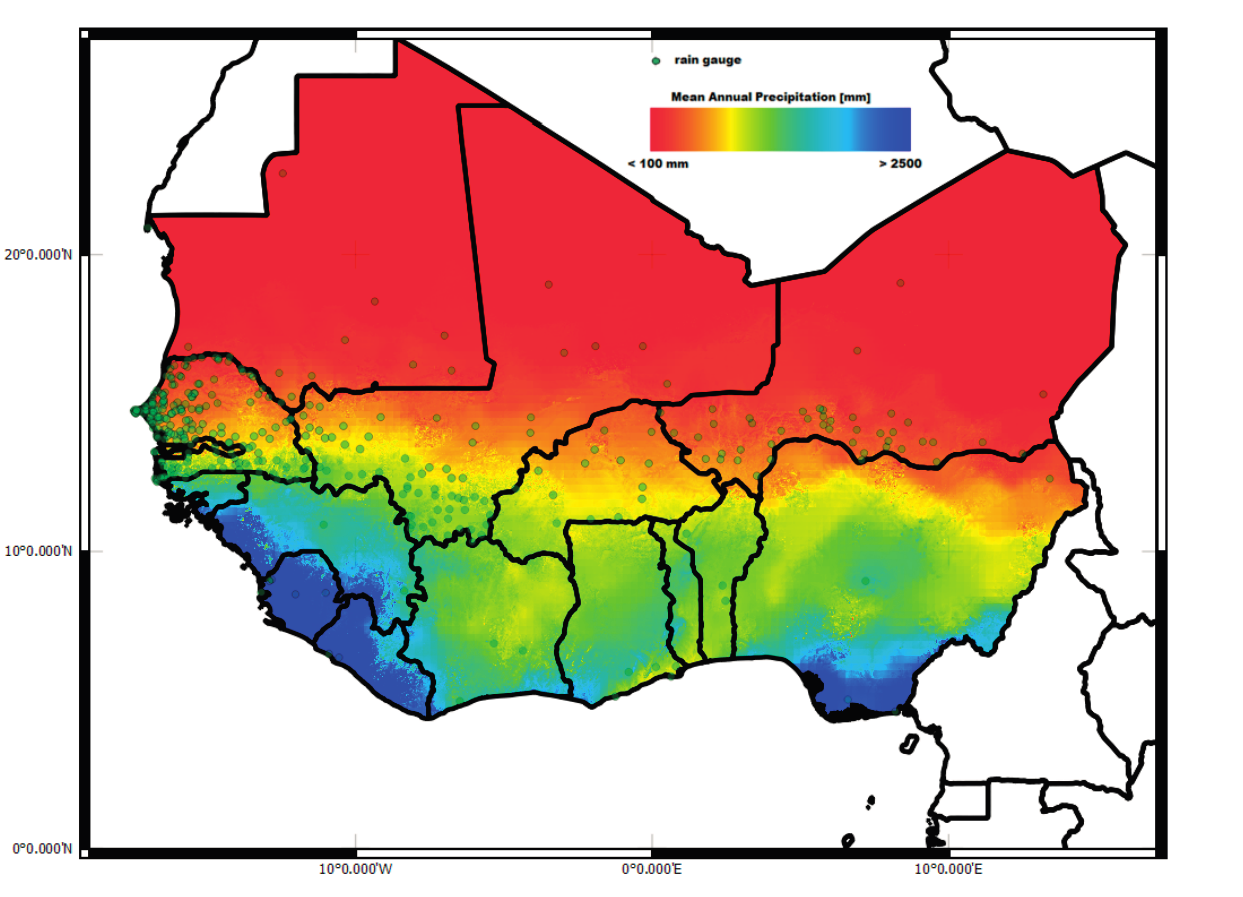
Figure 13. MAP of West Africa at 1 km using GPCC dataset. Green points represent the rain gauge stations against with the high resolution MAP product has been